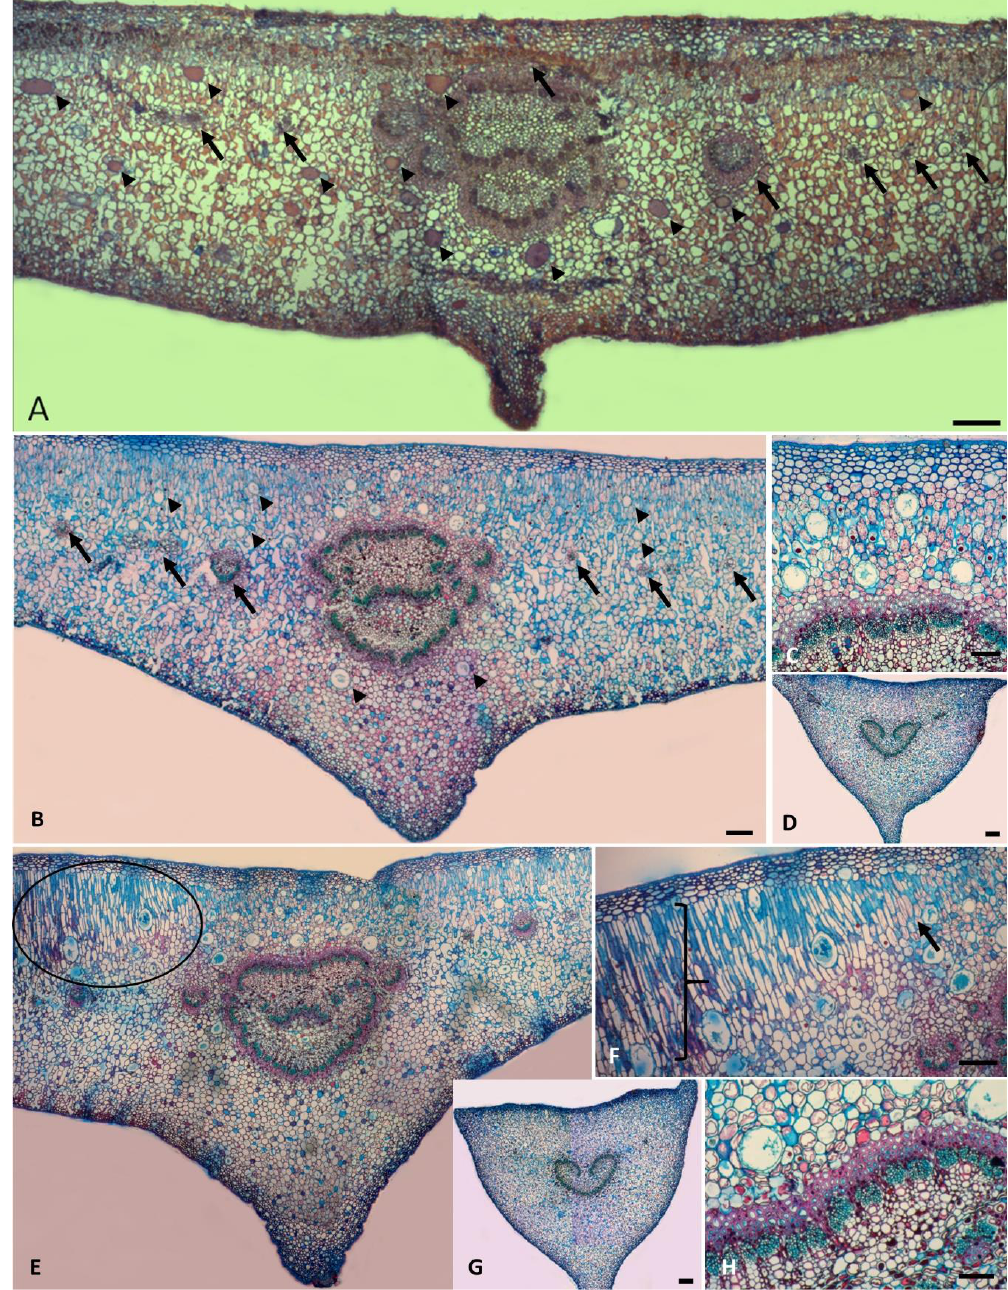
Figure 3. C. fluminensis. Non-galled leaves of female ( A ) and male individuals ( B – H ). ( A ) Transverse section (TS) of non-galled leaf in the midrib region. Note the flat-convex shape with a wing projection in the abaxial surface, several laticifers across the mesophyll (arrowhead), and the continuous palisade parenchyma (arrow). ( B , C ) Non-galled leaves of a male individual. Note the gender differences, regarding the flat-convex shape, and the abundance of laticifers surrounding the vascular region and across the palisade. ( D ) TS of non-galled petiole with several laticifers and idioblasts with phenolics across the cortex. Note the vascular system in open arc and the margins flexed downwards. ( E ) TS of the galled leaf, showing hypertrophy of palisade parenchyma and abundance of laticifers towards gall tissues (circle). ( F ) Adaxial surface of the galled leaf with galls Note the beginning of surface hypertrophy (arrow) from divisions and elongation of palisade cells (}) towards the gall system. ( G ) TS of petiole of galled leaf showing hypertrophy of cortex and abundant idioblasts with drusa. ( H ) Details of the midrib of galled leaf. Note the hypertrophy of vascular tissues and perivascular sclerenchyma sheath. Bars: ( A , B , D ) = 200 µ m; ( C , E , F ) = 100 µ m; ( D , G ) = 500 µ